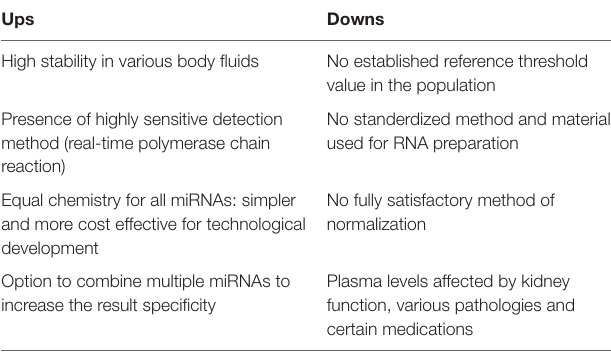
TABLe 2 | Critical analysis of microRNAs (miRNAs) as cardiac